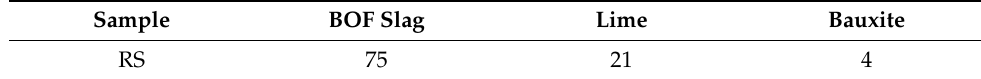
Table 2. Mix ratio of BOF slag reconstruction.